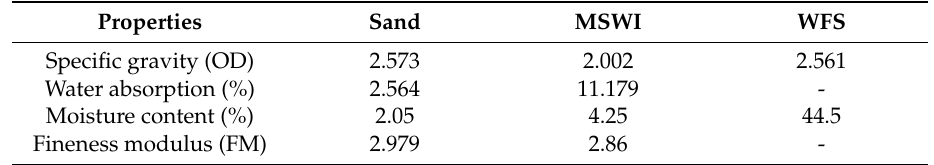
Figure 1. Particle size distribution of municipal solid waste incinerator (MSWI) and sand materials. Table 1. Sand, municipal solid waste incinerator (MSWI), and water filter silt (WFS) physical properties.